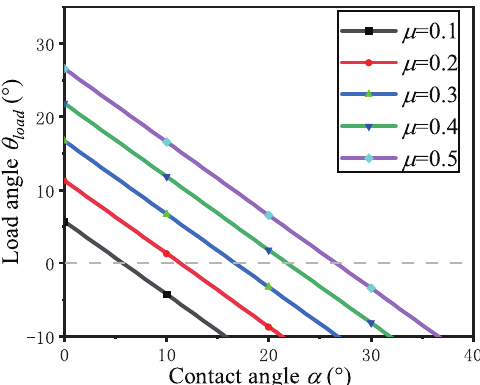
Figure 2. Relationship between the contact angle, the load angle, and the friction